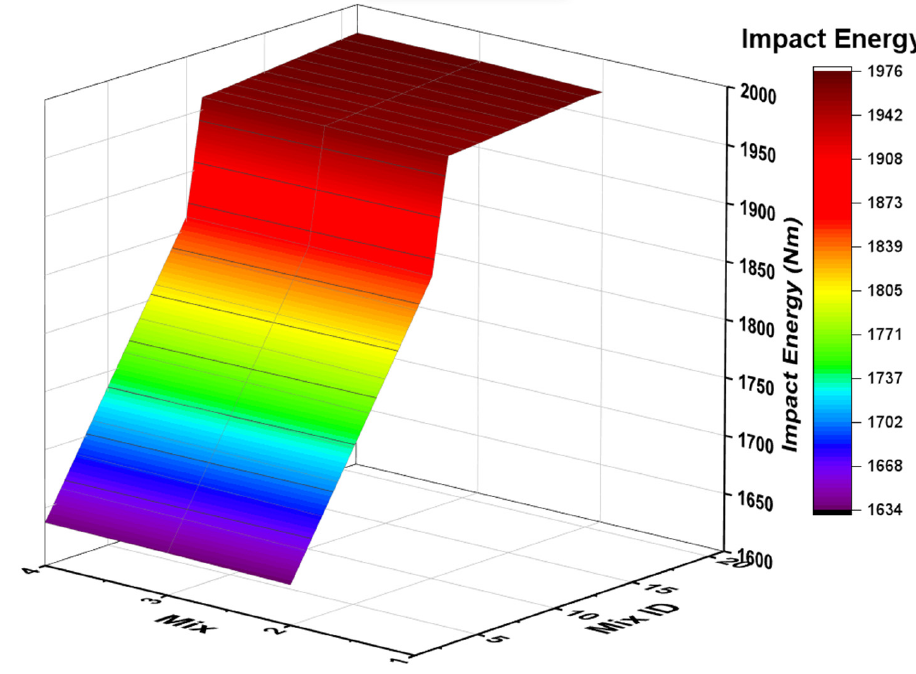
Figure 11. Three-dimensional impact tests plot for various A/B ratios. Red coloure indicates higher impact energy and yellow—medium whereas violet lower range.